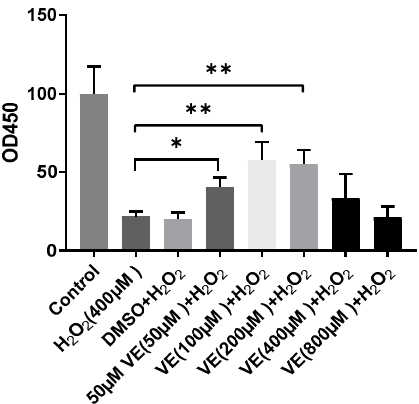
Figure 2. Hepatocytes’ survival rate detected by CCK-8 kit after being treated with 400 μ M H 2 O 2 , with or without pretreatment of various concentrations of vitamin E(VE). One-way ANOVA with Tukey’s test was applied. Data are expressed as mean ± SD; the symbol * means p < 0.05 , and ** means p < 0.01.